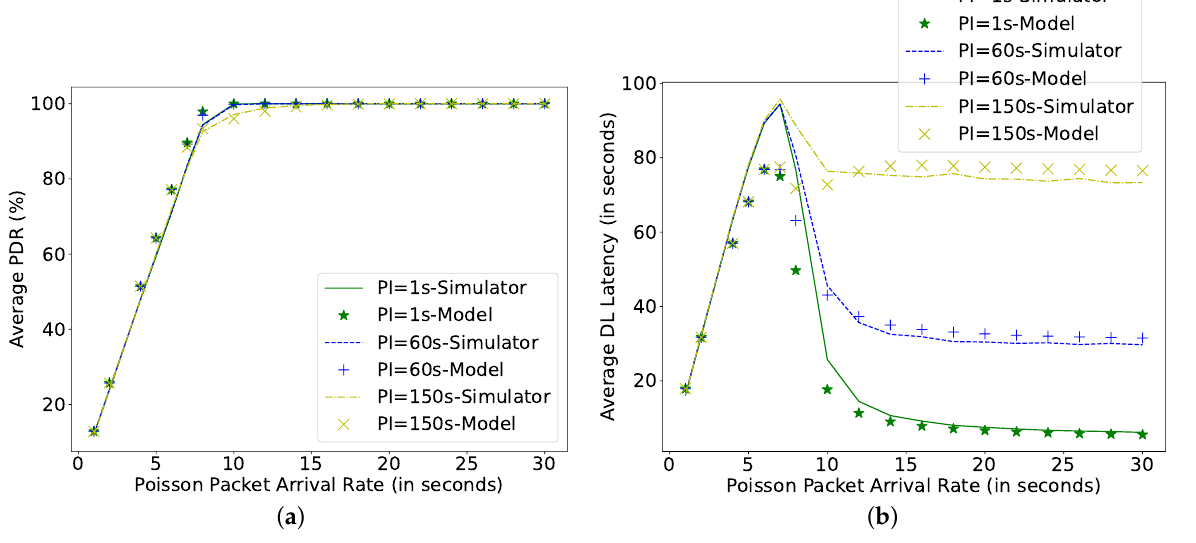
Figure 14. Comparing simulator and model for different packet arrival rate at C = 0.1 mF, P h = 0.1 mW, N = 16. ( a ) Average packet delivery ratio; ( b ) DL